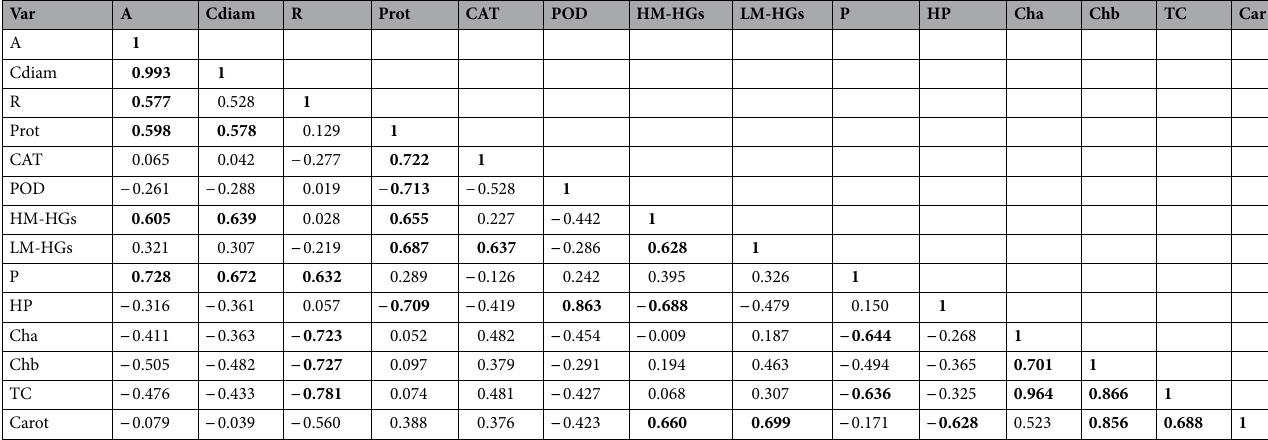
Table 3. Pearson correlation matrix of the anatomical, biochemical and pectin content parameters. Values in bold are different from 0 with a significance level alpha =